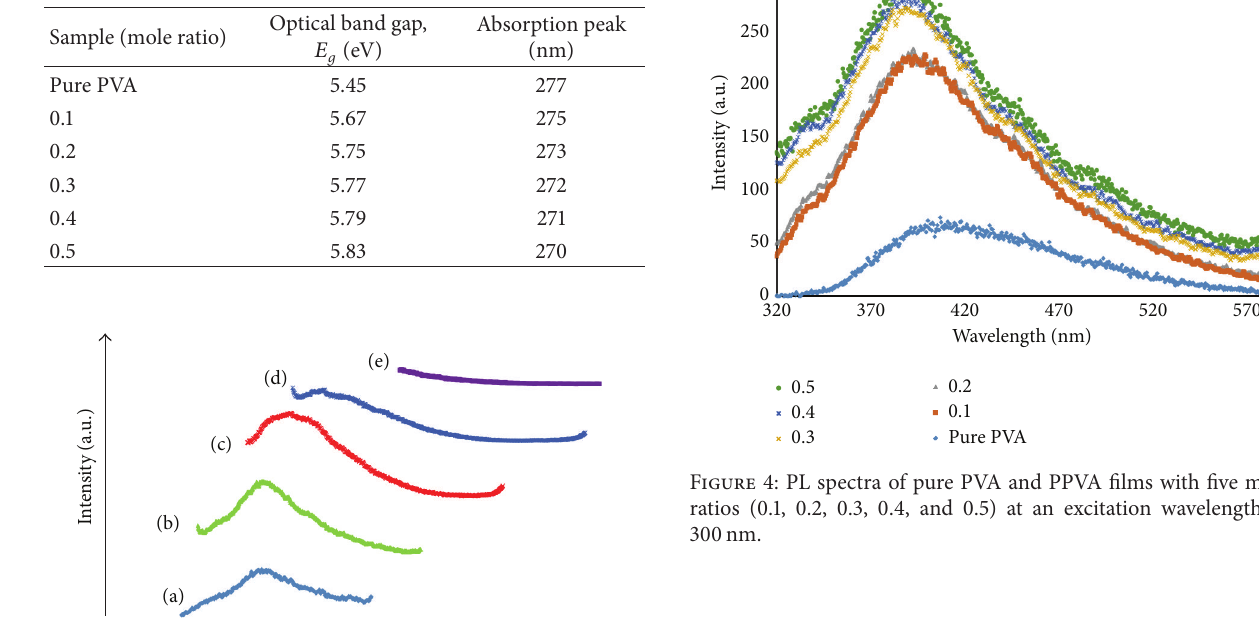
Table 1: Optical parameters for pure PVA and PPVA films.